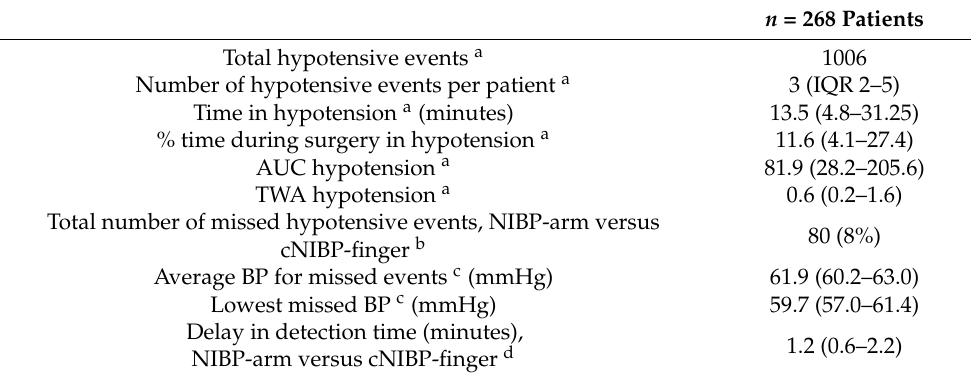
Table 2. Hypotensive events detected with cNIBP-finger versus NIBP-arm.